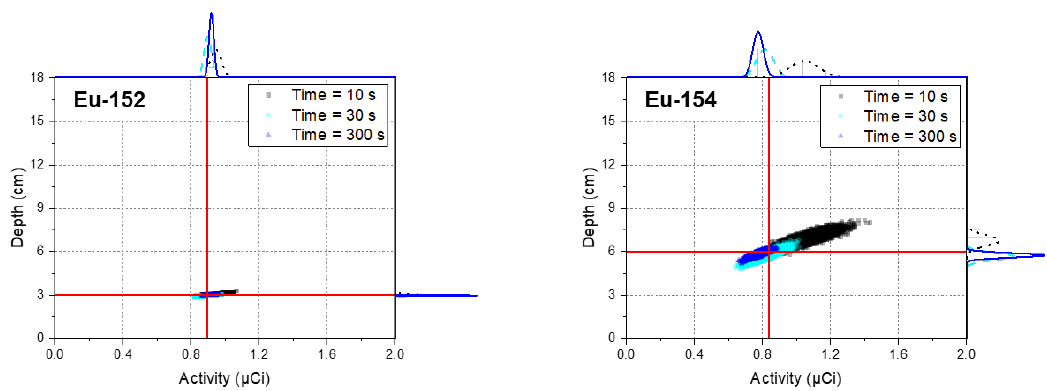
Figure 8. Joint distributions between the depth and activity of identified radioisotopes (i.e., Eu-152 and Eu-154) for experimental spectra acquired with 10 s, 30 s, and 300 s for Eu-152 and Eu-154 sources buried in sand at depths of 3 cm and 6 cm, respectively. The scatter dots represent the correlations between the depth and activity, while the red lines and the curves outside the plot area represent their true values and corresponding densities, respectively.